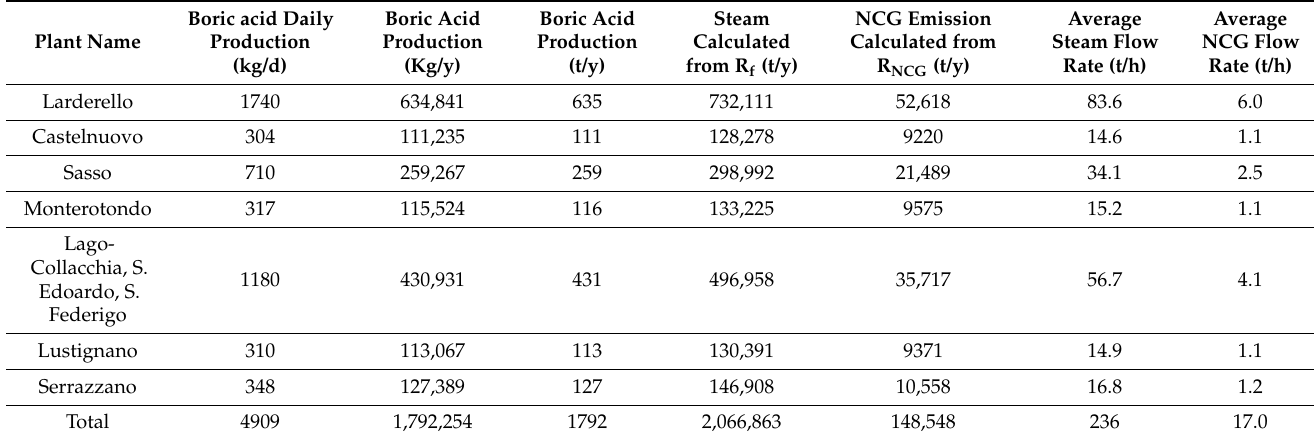
Table 5. Calculated NCG emission from data from boric acid production data according to ref. [37] and their distribution in factories in